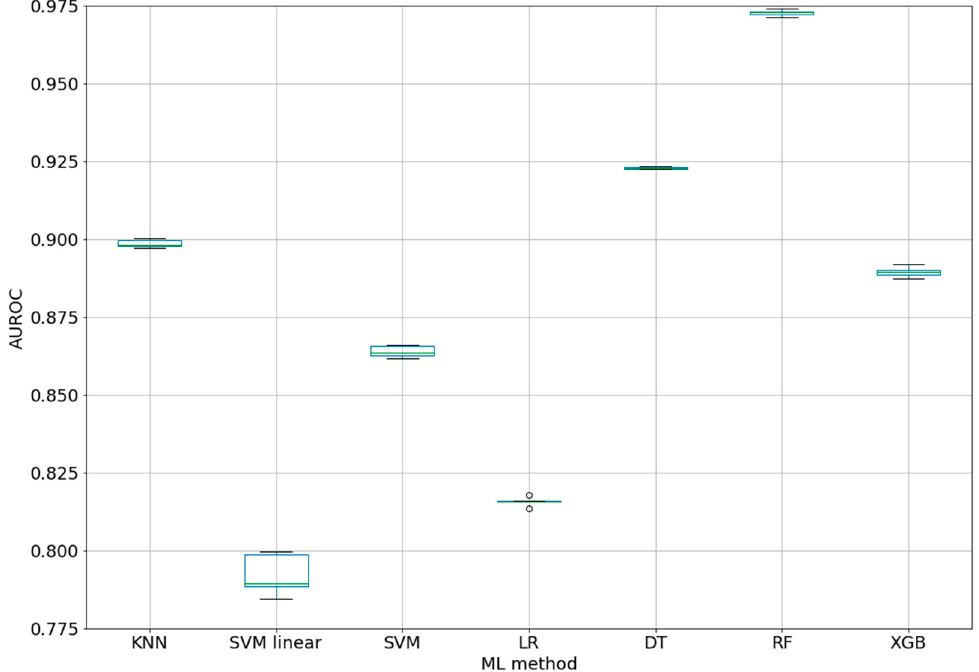
Int. J. Mol. Sci. 2019 , 20 , x FOR PEER REVIEW Figure 1. Box-plot for AUROC values of ML classifiers (five-fold CV). Figure 1. Box-plot for AUROC values of ML classifiers (five-fold CV).